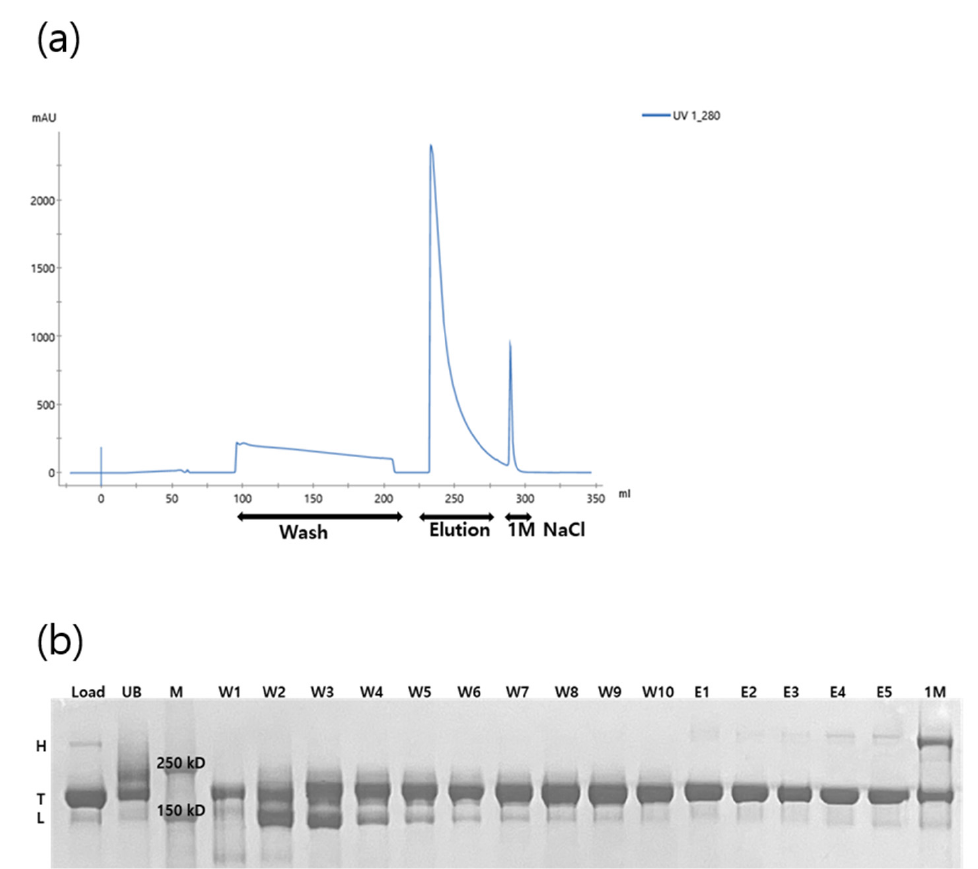
Figure 4. Chromatogram and SDS-PAGE results using the step gradient mode ( a , b ). Band H: HMW proteins, band T: target protein, band L: LMW proteins. The sample was loaded with 10 g/L of resin. The wash step was performed at a conductivity of 50 mS/cm for 10 CV.